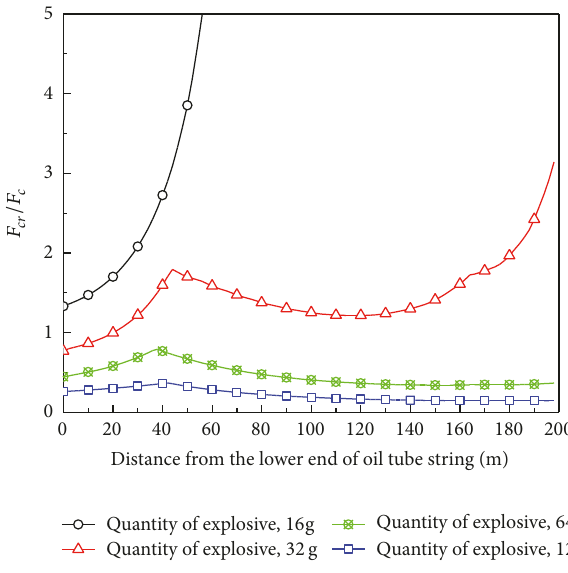
Figure 18: Effect of charge quantity on the buckling mechanical behavior of oil tube